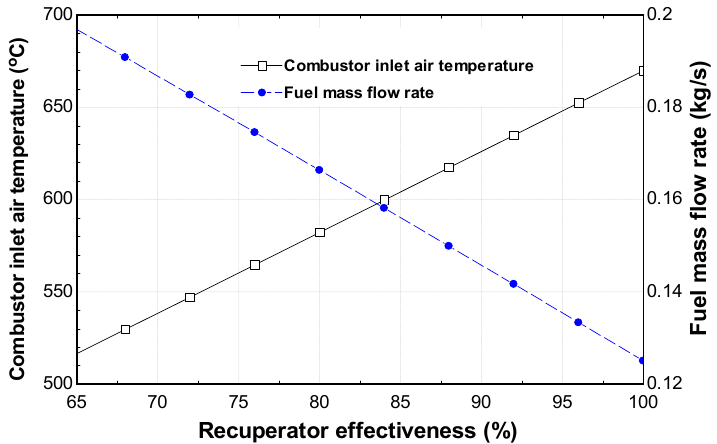
Figure 7. Effect of the recuperator effectiveness on the fuel mass flow rate and recuperator exit temperature.